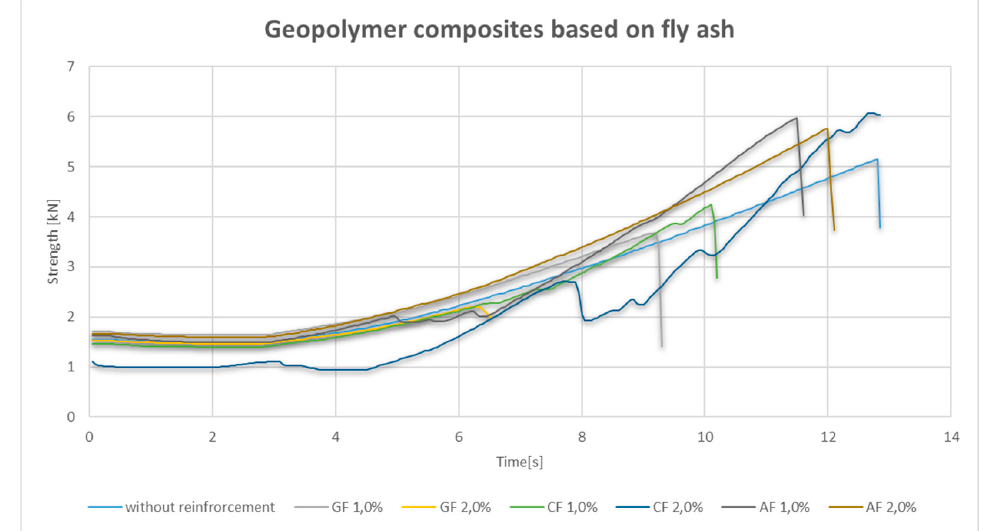
Figure 3. Strength–time graph for the bend test for fly ash composites. Composites based on metakaolin reinforced with glass and carbon fibers behaved